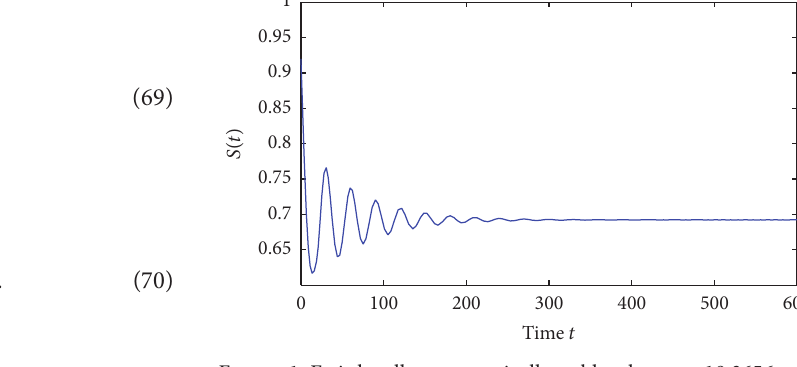
Figure 1: 𝐸 + is locally asymptotically stable when 𝜏 = 18.3656 < 𝜏 0 with initial value “ 0.92, 0.155, 0.112 .”